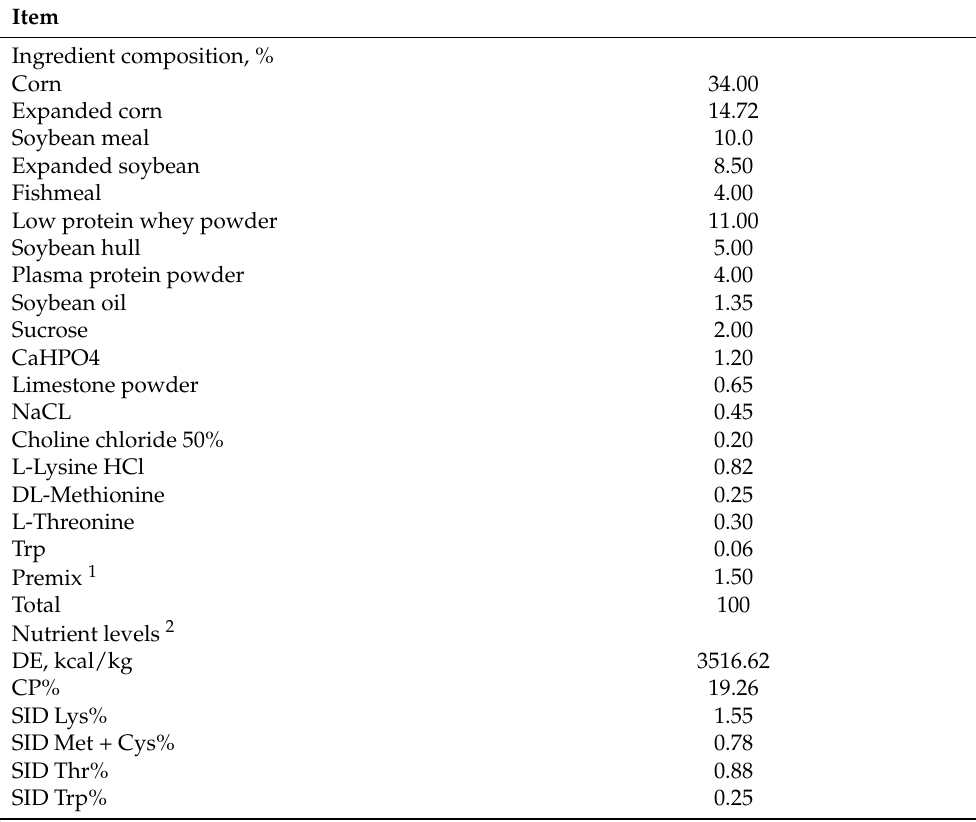
Table 2. Ingredient composition and nutrient levels of the basal diet (%, as-fed